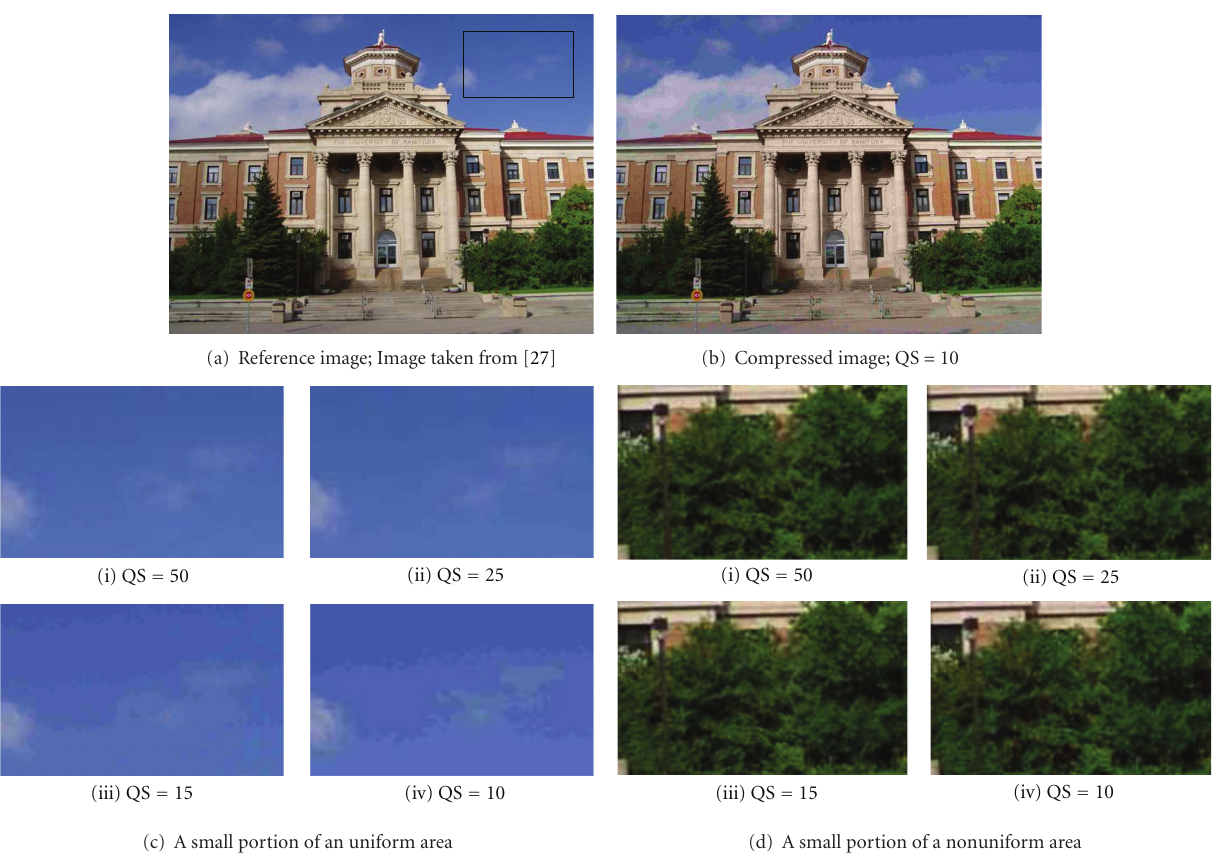
Figure 1: Variation of perceived distortion (uniform and nonuniform